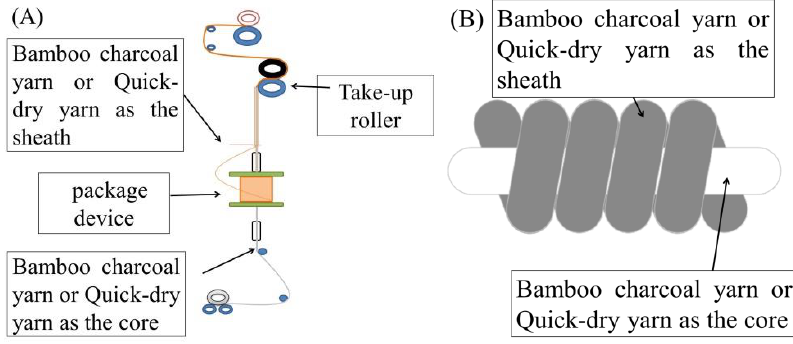
Figure 2. ( A ) assembly of hollow spindle machine and ( B ) diagram of a wrapped yarn [26].